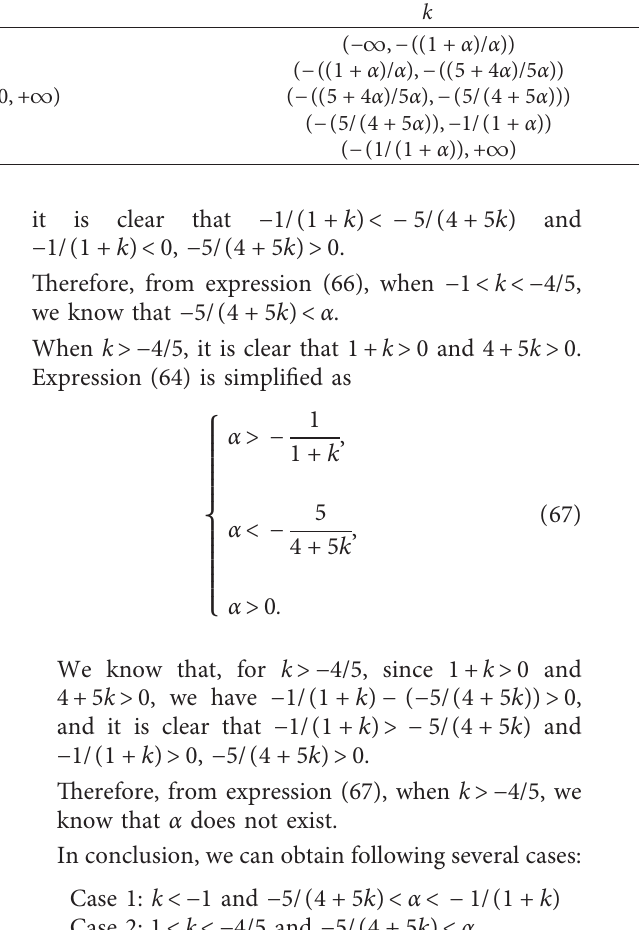
Table 1: Stability criterion for scenario 1( α is fixed and k is the control parameter). α